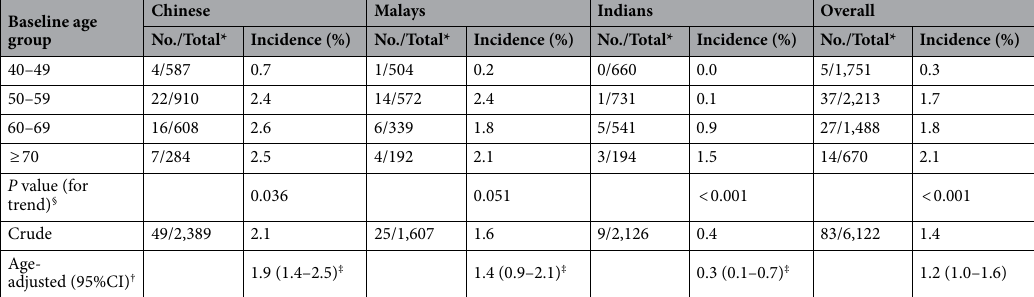
Table 2. Incident pterygium stratified by age groups and across the ethnic groups of Chinese, Malays, and Indians. CI confidence interval. *Number of cases/numbers at risk. § Cochran—Armitage trend test. † Standardized to 2010 Singapore population census. ‡ P values for age-adjusted incidence between the 3 ethnic groups are: Chinese vs. Indians, P < 0.001; Malays vs. Indians, P = 0.005; Chinese vs. Malays, P = 0.771.